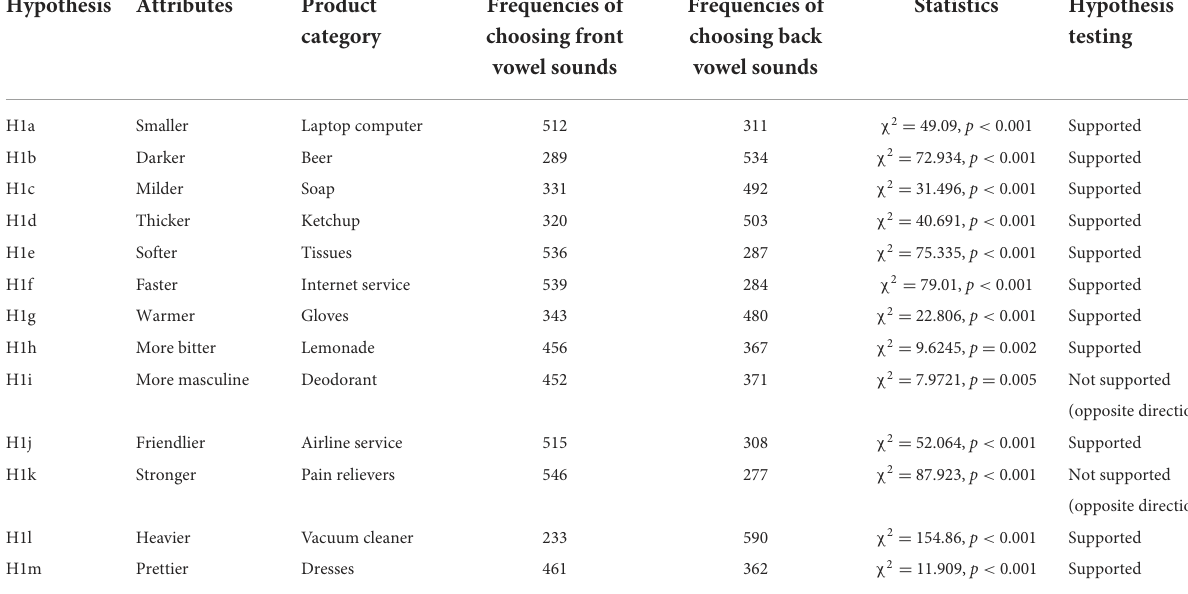
TABLE 2 Summary of findings that the current research replicated Klink (2000).